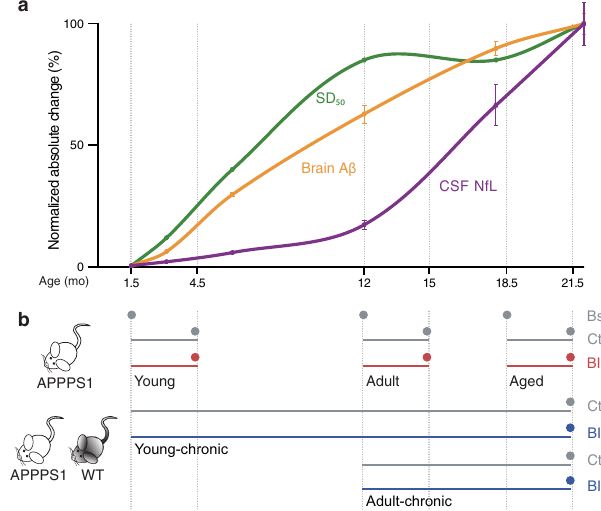
Fig. 1 | Age-dependent biomarker changes in APPPS1 mice and experimental group design. a Normalized absolute changes (%) in brain A β levels, brain A β seeding activity (SD 50 ),and CSFNfLasafunctionofage inAPPPS1mice. Data were largely taken from previous publications (for brain A β measured by immunoassays 13 ; for in vivo A β seeding activity (Reed-Muench method) 13 ; for CSF NfL 11 and from in-house mouse bio-/databank (see Supplementary Table 1; note that,fromeachoftheNfLvaluesofAPPPS1mice,themeanoftheNfLvaluesofage- matched wild-type mice was subtracted since wild-type mice also show an age- related increase 59 ). Means and ± s.e.m. are shown and curves were generated in Numbers (Apple Inc., Cupertino, CA) using the “ curved connection line ” option. ResultsrevealasteadyincreaseinbrainA β untilitslowsdownatalateage,whereas A β seeding activity increases more rapidly and reachesaplateauasearly as~12-mo of age (see also Fig. 3c where log SD 50 data are plotted using the curve- fi tting method).CSFNfLincreasesslowlyuntil~10 – 11-mo of age, afterwhichamorerapid increasetakesplace. b Experimentaltreatmentgroupscoverdistincttime-pointsof decisive biomarker changes. Mice were treated either with BACE1 inhibitor- (BI) containing food pellets (red) or control (Ctrl) food pellets (gray). Three-month treatmentperiods(short-term)startedwhenanimalswere1.5(young),12(adult),or 18.5 (aged) mo of age, and mice were analyzed at the end of each 3-month treat- ment period (dots). To assess baseline levels (Bsl), untreated mice were also col- lectedat1.5,12,and18.5moofage(dots).ChronicBItreatments(blue)startedat1.5 or12monthsofageandlasteduntil21.5months(young-chronicandadult-chronic, respectively) when the animals were sacri fi ced. Chronic BI treatments were also administered to control wildtype (WT) mice. Number of mice per group was n =9 – 16; for exact numbers see Supplementary Fig.